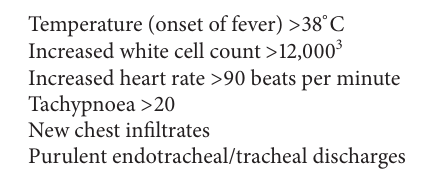
Table 2: Distribution of bacterial pathogens associated with nosocomial infection in relation to site of specimen. Pathogen Respiratory tract 𝑁 = 125